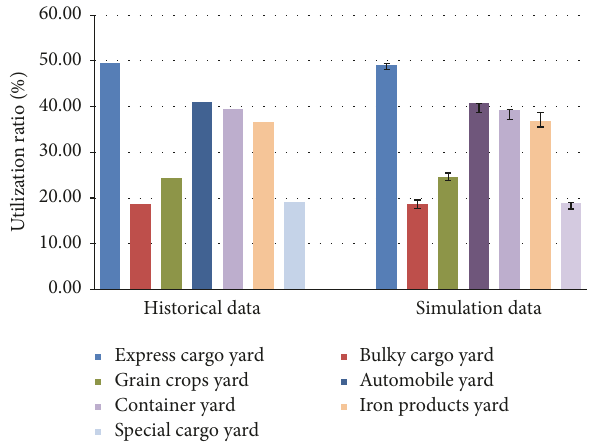
Figure 18: Historical and simulated utilization ratio of handling machineries.